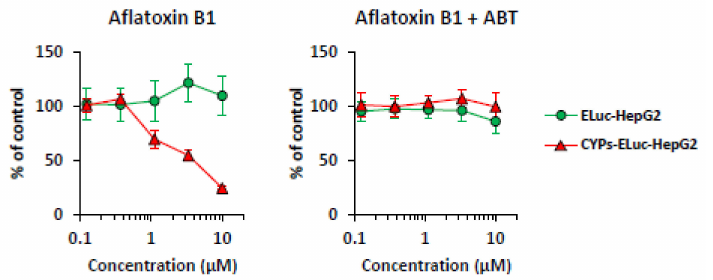
Figure 3. Effects of aflatoxin B1 and ABT on bioluminescence intensity in ELuc-HepG2 and CYPs- ELuc-HepG2 cells. ELuc-HepG2 (circles) and CYPs-ELuc-HepG2 cells (triangles) were treated with aflatoxin B1 in the absence (left panel) or presence (right panel) of 1 mM ABT. After 3 days, bioluminescence intensity was measured non-destructively for 5 s. Data are expressed as percentage of vehicle control cells (set at 100%) and shown as means ± standard deviations ( n =